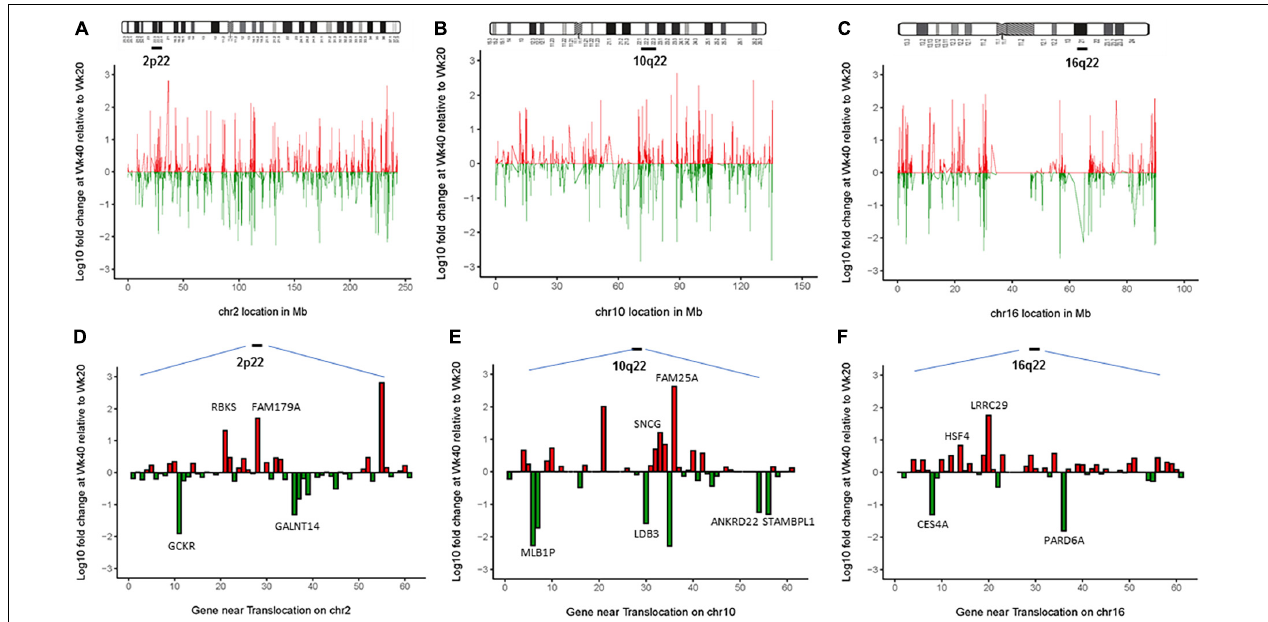
FIGURE 4 | The chromosomal translocations alter the transcriptional landscape of the Barrett’s epithelial cells. Top panel (A–C) represents the entire altered transcriptional landscape of the three chromosomes 2, 10, and 16 in BEC40W compared with BEC20W cells (red: upregulation, green: downregulation of transcript levels). Bottom panel (D–F) shows log10 fold changes in FPKM transcript levels of genes in the chromosome loci spanned by FISH-EA probes (2p22, 10q22, and 16q22 marked by a bar). The graph represents fold changes in FPKM transcript levels of known genes located in the same regions. Genes altered more than twofold ( p < 0.025) are listed in the tables with individual fold changes shown in red/green representing up/downregulation. The complete list of genes in these regions and the fold change in their transcript levels between BEC40W and BEC20W cells is provided in Tables 2–4 . Random genes were selected, and expression levels were confirmed by qPCR (genes with LOC entries are pictured but not labeled on the